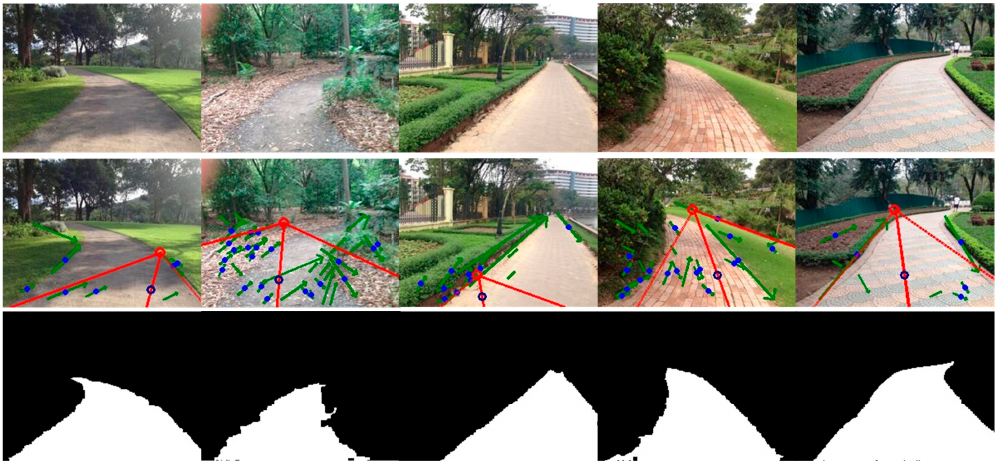
Figure 8. Examples of segmentation with the proposed method under conditions of inaccurate vanishing point and dominant borders. Row 1: input images, Row 2: vanishing point and dominant borders, Row 3: segmentation.